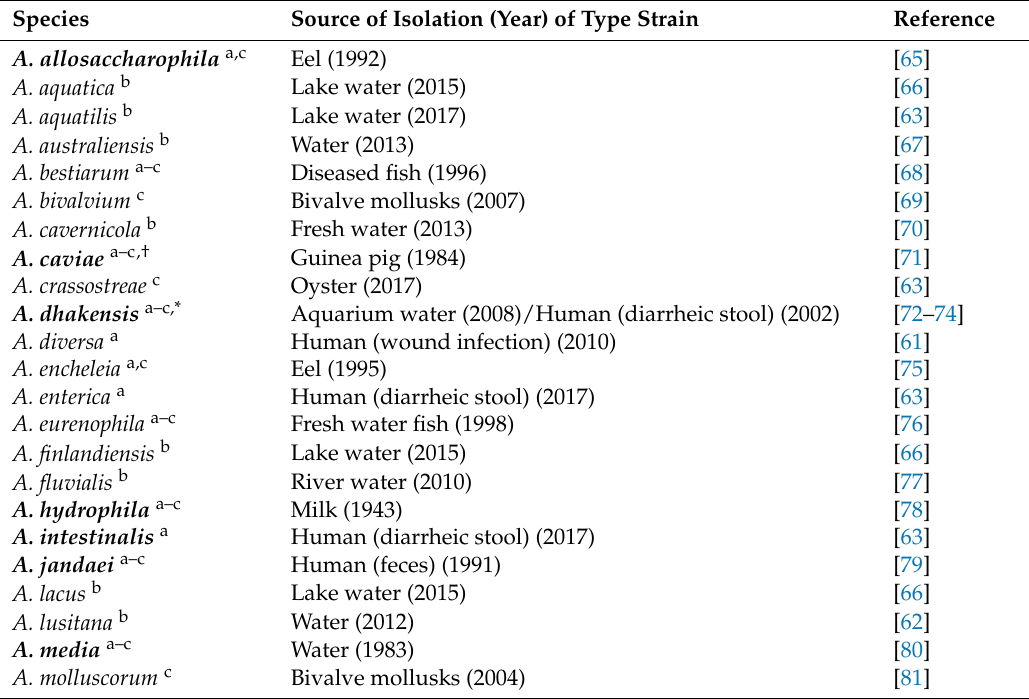
Table 2. Currently recognized species belonging to the genus Aeromonas and the source of isolation of the type strain. The species in bold represent the most prevalent clinical species and lowercase superscript letters indicate that the species have been isolated from clinical species (a), water (b), and fish/seafood (c) (The table is adapted and modified from